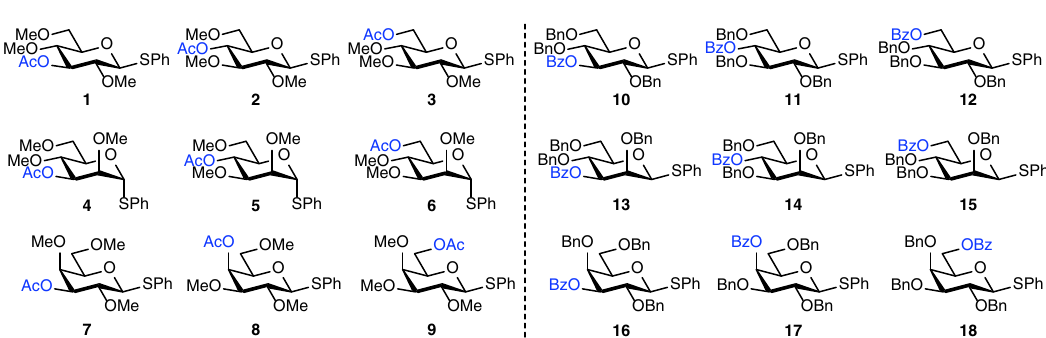
Fig. 2 S -phenyl donors equipped with ester protection groups on systematically varied positions on the ring. a Glycosyl donors used for IRIS experiments and DFT computations. Donors 3 – 9 and 13 – 15 were converted into their corresponding sulfoxides prior for the IRIS experiments to improve the yield of the glycosyl cation generation 33 . b Glycosyl donors used for chemical glycosylation reaction